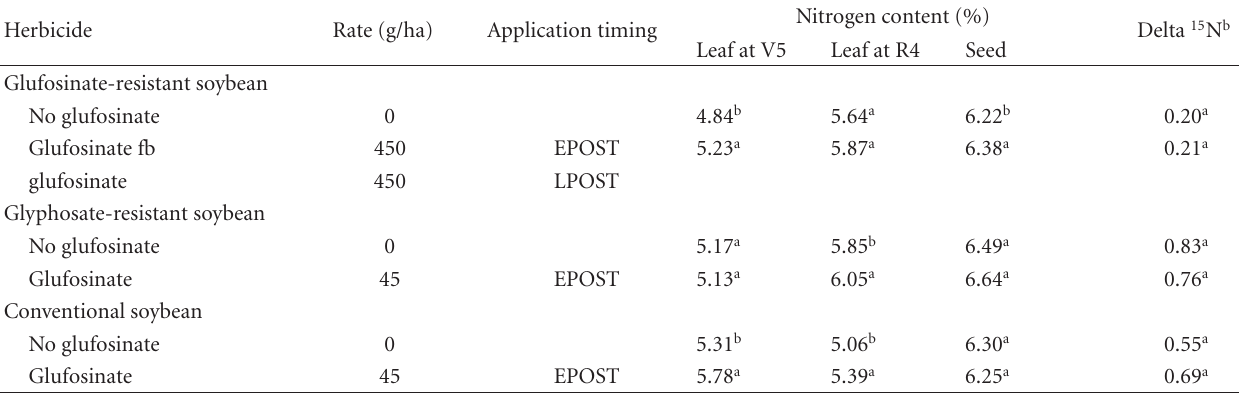
Table 5: E ff ect of glufosinate application on leaf and seed nitrogen content and delta 15 N in glufosinate-resistant, glyphosate-resistant, and conventional soybean in a field study at Stoneville, MS, 2009 and 2010 a .